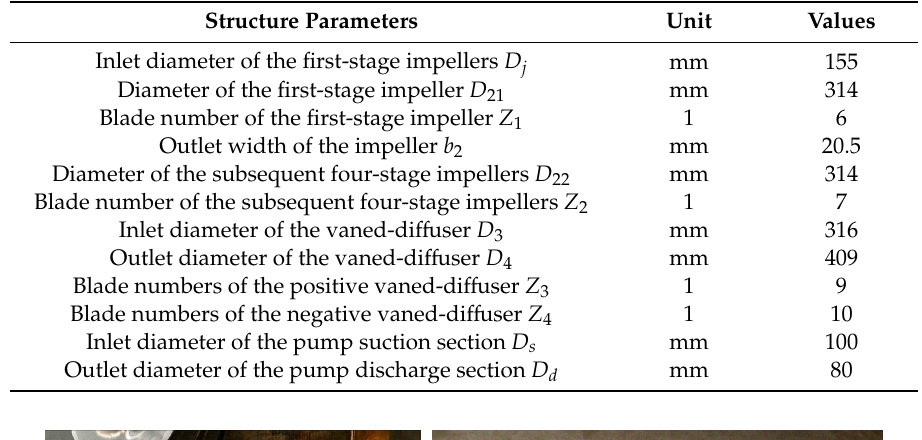
Table 1. Main structure parameters.